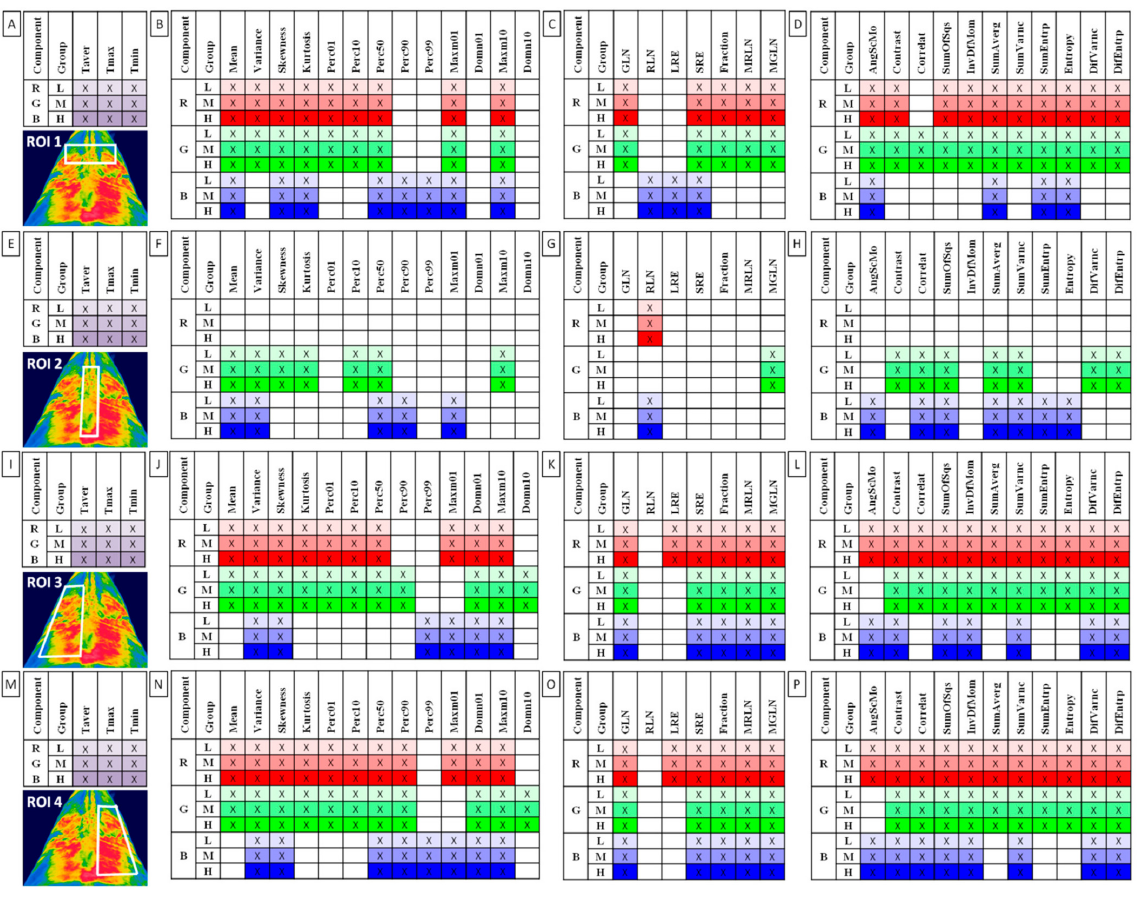
Figure 2. Features of ( A , E , I , M ) conventional thermography, ( B , F , J , N ) histogram statistics, ( C , G , K , Q ) gray-level run-length matrix and ( D , H , L , P ) gray level co-occurrence matrix for exam- ined color components (R, red; G, green, B, blue) were found to be significantly different between the pre-exercise and post-exercise imaging for all rider groups (L, light; M, moderate; H, heavy). Data were presented separately for each region of interest (ROI 1-4) annotated here on the sam- ple thermal image. Taver—average temperature; Tmax—maximal temperature; Tmin—minimal temperature; Skewness—skewness coefficient; Perc01, Perc10, Perc50, Perc90, Perc99—percentiles; Domn01, Domn10—dominants; Maxm01, Maxm10—maximum of moments; GLN—gray level non- uniformity; RLN—run-length nonuniformity; LRE—long-run emphasis; SRE—short-run emphasis; Fraction—the fraction of image in runs; MRLN—run-length nonuniformity moment; MGLN—gray level non-uniformity moment; AngScMom—angular second moment/energy; Correlat—correlation; SumOfSqs—sum of squares; InvDefMom—inverse different moment/homogeneity; SumAverg— summation mean; SumVarnc—summation variance; SumEntrp—summation entropy; DifVarnc— differential variance; DifEntrp—differential